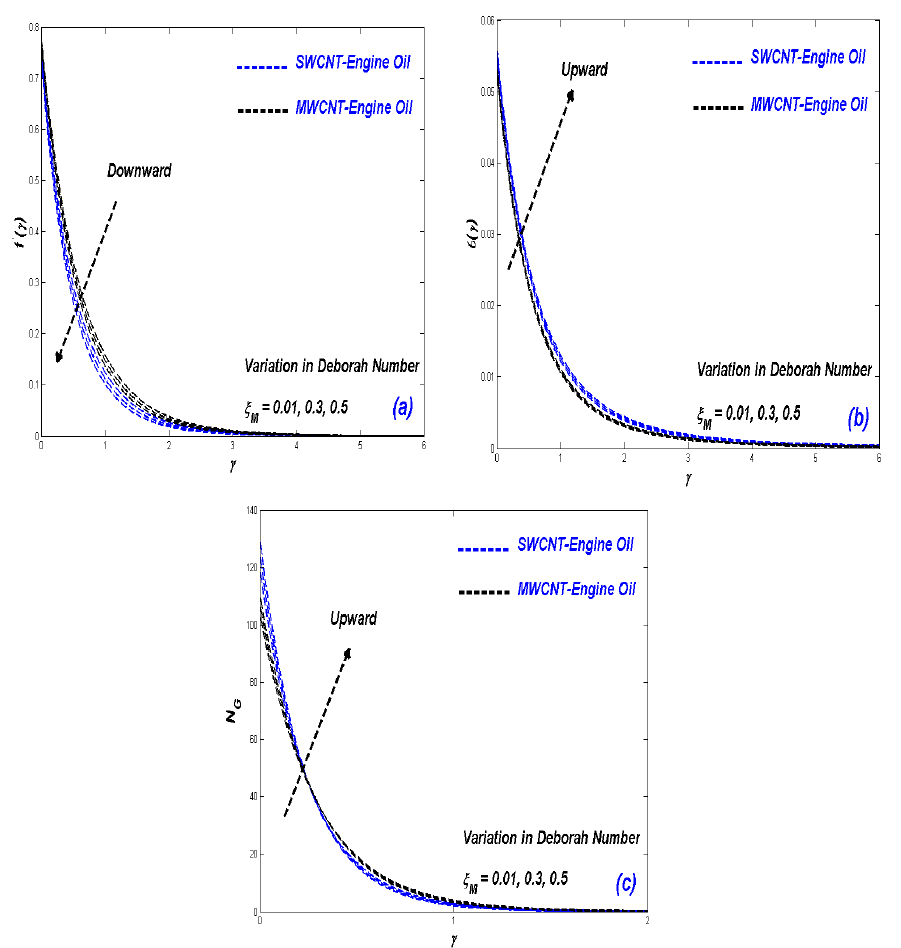
Figure 5. ( a ) Velocity change with 𝜉 (cid:3014) ; ( b ) Temperature change with 𝜉 (cid:3014) ; ( c ) Entropy change with 𝜉 (cid:3014)